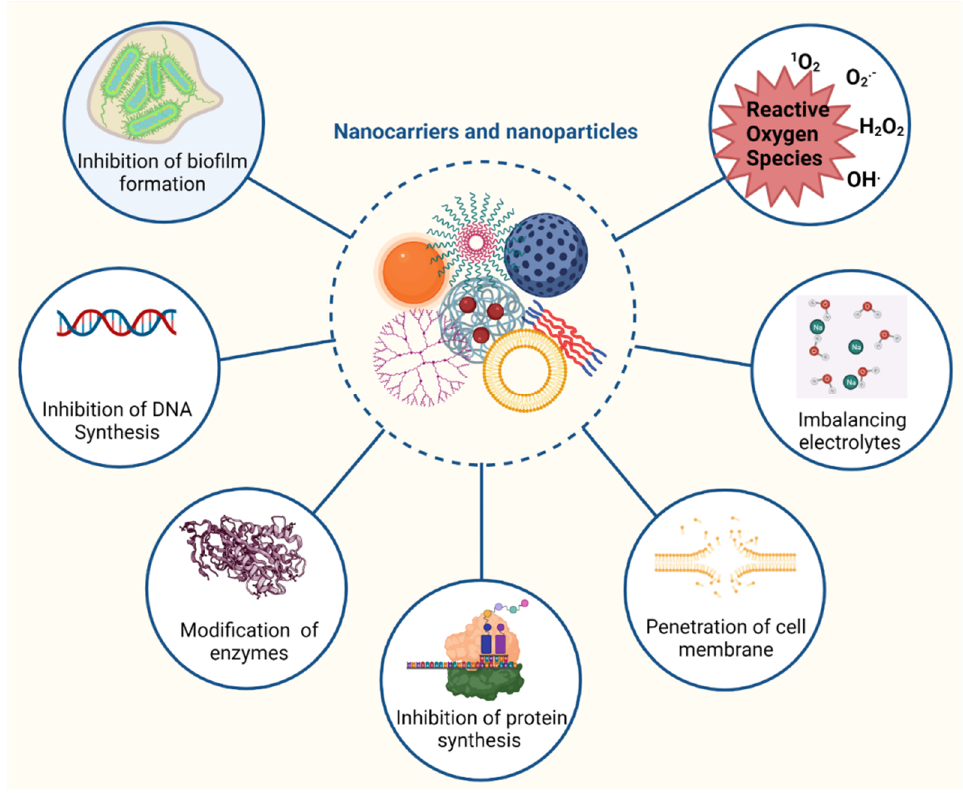
Figure 2. The most common mode of actions of antibiotics loaded in nanoparticles.